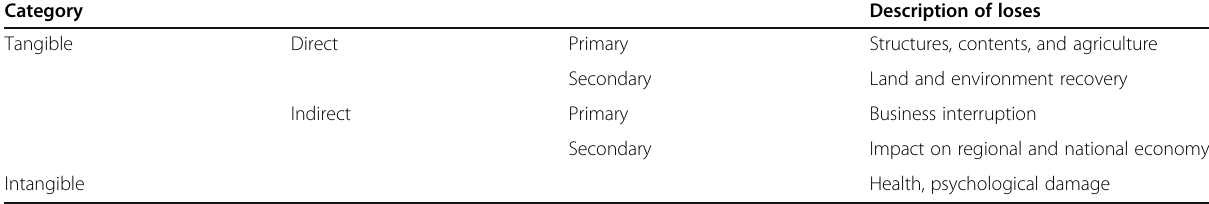
Table 3 Flood damages categories and loss examples [36]